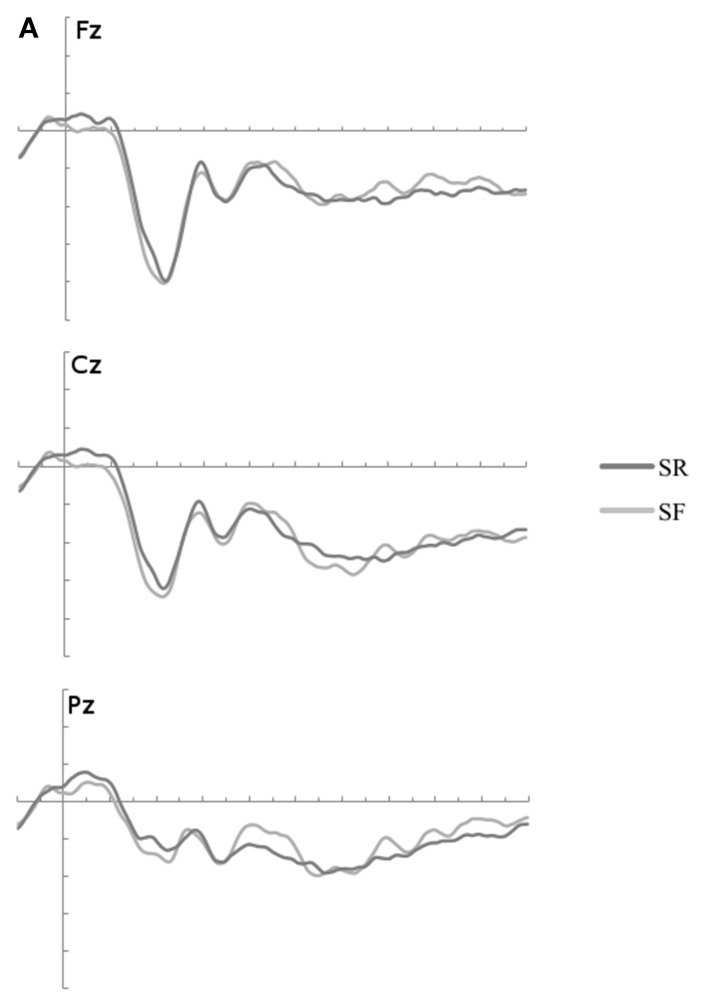
(A) The ERP waveforms to restudied items which were later remember and forgotten (SR/SF) were not significantly different at any time windows of interest. (B) ERP waveforms to all restudied items (RS) and tested items categories by Memory Condition (RR, RF, FF). ERPs are plotted from 100 ms before stimulus onset to 1000 ms thereafter at frontal, central and posterior midline sites: Fz, Cz, and Pz. Three time windows of interest are marked in gray. The waveforms were low-passed filtered at 12 Hz for illustration. RR, remembered; RF, later forgotten; FF, immediately forgotten.